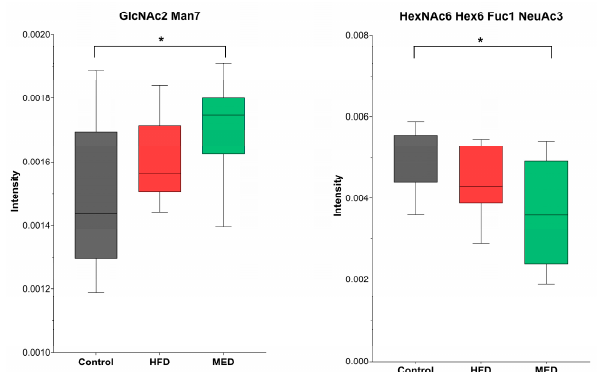
Figure 3. Boxplots showing increased and decreased abundance at week 12 for each statistically significant N-glycan (* p -value < 0.05, ** p -value < 0.01, *** p -value < 0.001). Moreover, statistically significant differences were observed in three oligomannose glycans. They were increased in both the HFD group and MED group compared to the CTRL group, except for M11 which was decreased in the HFD group vs. the CTRL group.